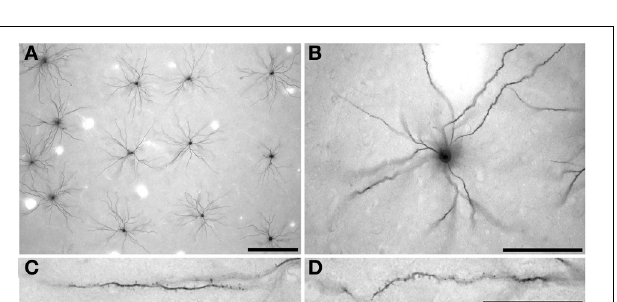
FIGURE 2 | Low- (A) intermediate- (B) and high- (C,D) power photomicrographs of layer III pyramidal cells in primary visual cortex of the greater cane rat ( Thryonomys swinderianus ) that were injected with Lucifer Yellow and processed for a DAB (3,3 (cid:2) -diaminobenzidine) reaction product. Cells were injected in a grid-like pattern (A) , with each cell being sufficiently spaced from other to avoid cluttering of dendrites (B) . The apical dendrite is observed at low and intermediate power in tangential sections ( A,B , respectively) as a black dot over the cell body, due to the extra depth of DAB precipitate in the issuing process as compared with the surrounding cell body. (C) and (D) indicate the spine density along the basal dendrites of the layer III pyramidal cells, where the cell body is to the right and the distal tips of the dendrites to the left. Scale bar in (A) = 250 µ m, scale bar in (B) = 100 µ m, and the scale bar in (D) = 50 µ m and applies to (C) and (D) .